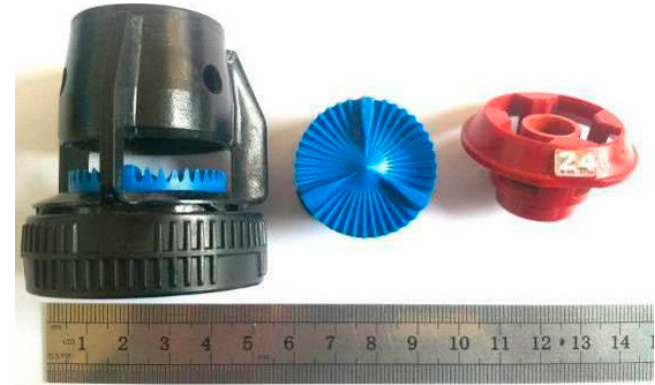
Figure 1. Fixed spray-plate sprinkler (FSPS) used in the investigation.